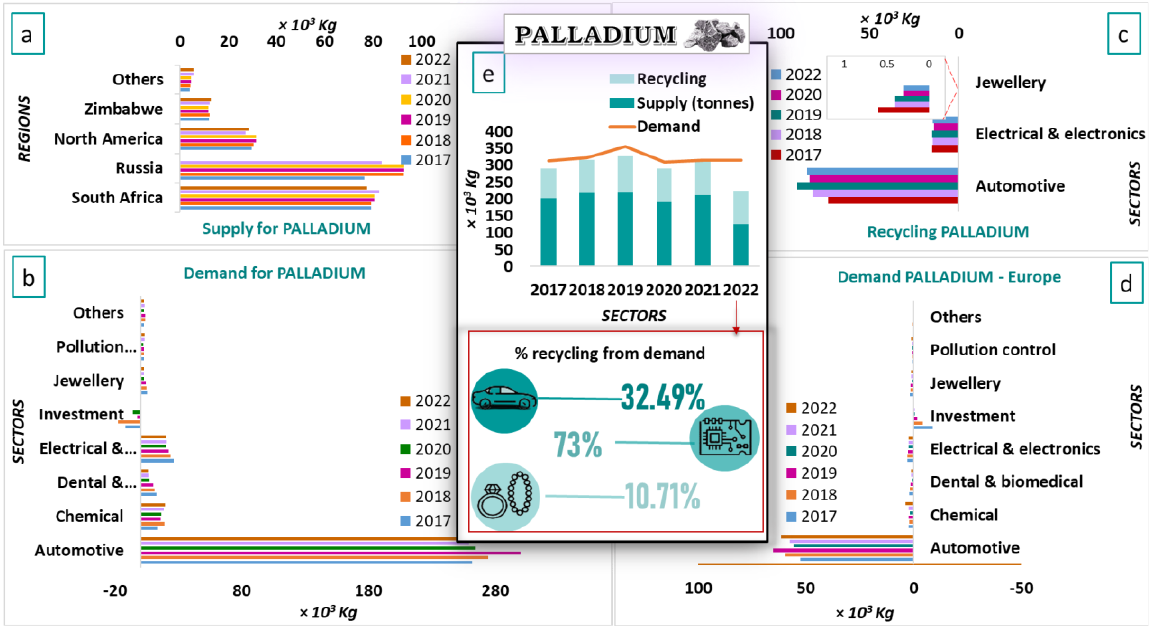
Figure 5. ( a ) Palladium supply by region from 2017 – 2022; ( b ) Palladium demand by sectors from 2017 – 2022; ( c ) Palladium recycling by sectors from 2017 – 2022; ( d ) Palladium demand in Europe from 2017 – 2022; ( e ) Global palladium recycling, supply and demand from 2017 – 2022 (according to the data from [49]).